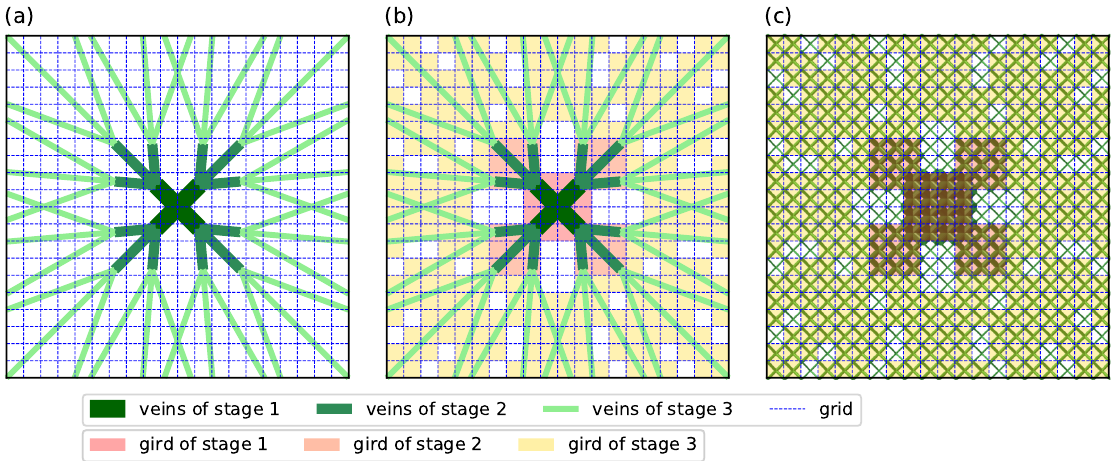
Figure 7. Bionic model mapping design method. ( a ) 2D grids of lattice structure. ( b ) 2D grids collections of different stages. ( c ) 3D lattice structure collections obtained by 2D grids